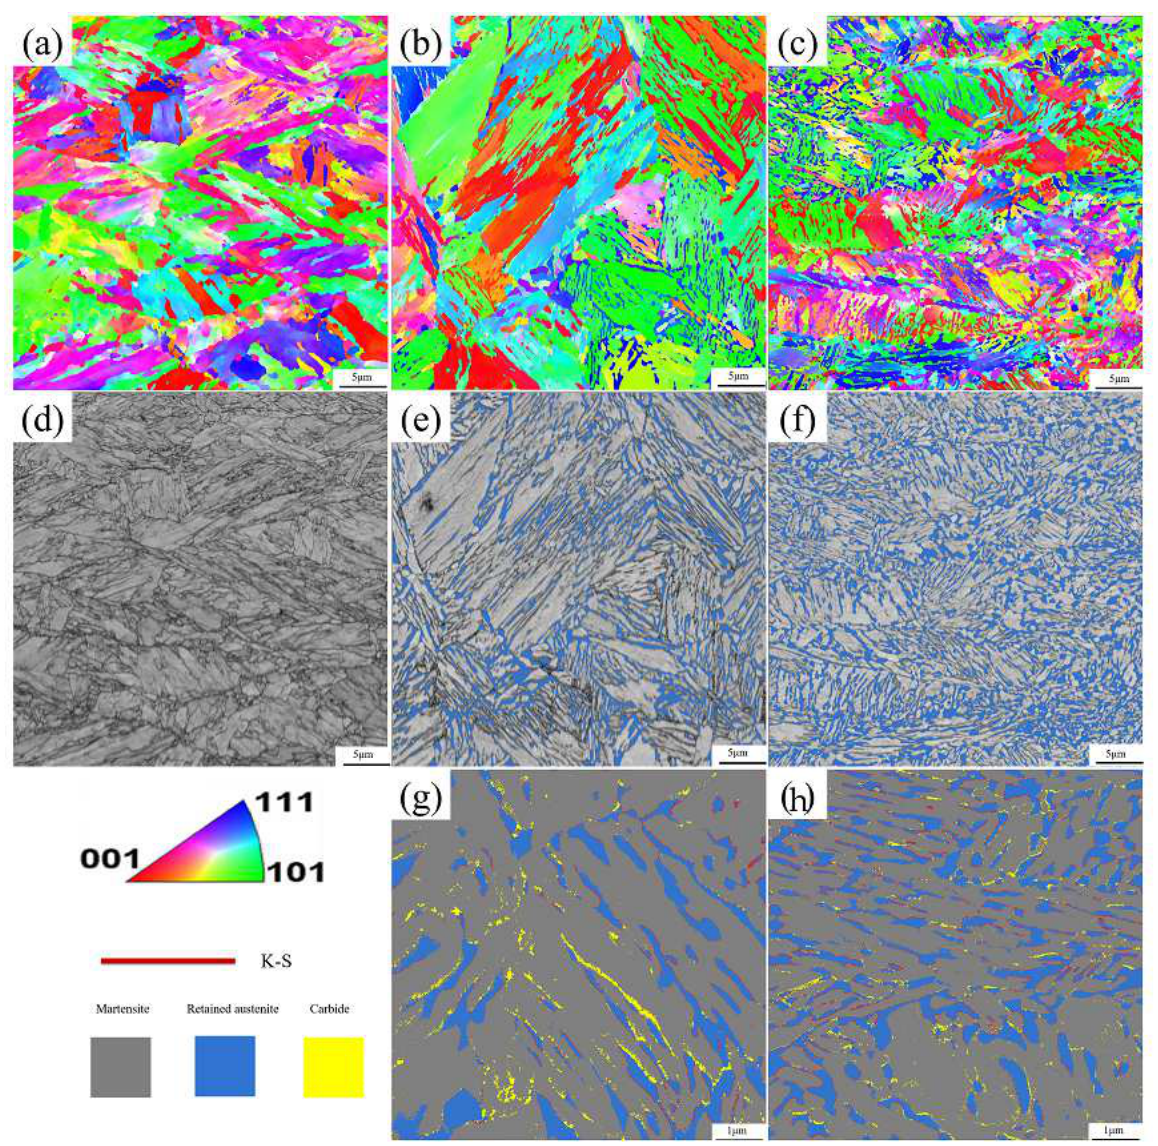
Figure 10. ( a – c ) are the IPF maps of QP-300, IA-680 and QA-680 processes; ( d – f ) are phase composition diagrams of QP-300, IA-680 and QA-680 processes; ( g , h ) are partial enlargements of ( e , f ).